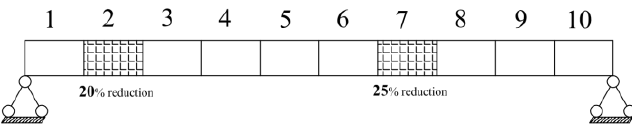
Figure 4. beam-type bridge model.